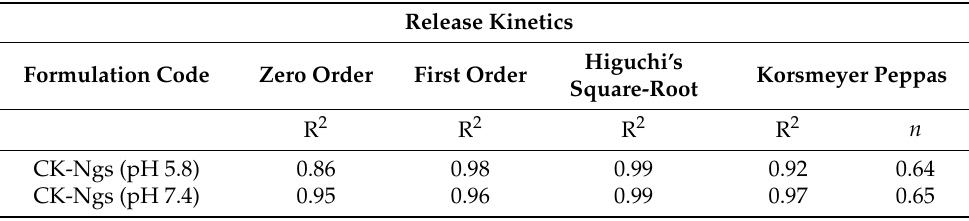
Table 2. The release kinetics of CK-Ngs under different pH environments.